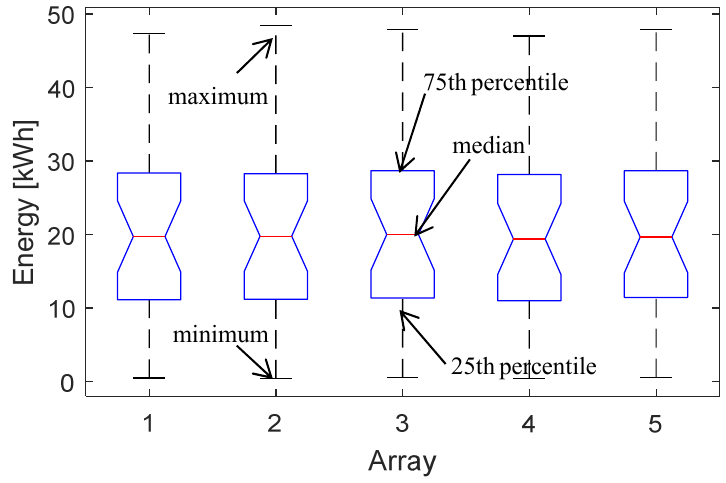
Figure 4. Box plot of ANOVA test of the five distributions for the one-month analysis (January).